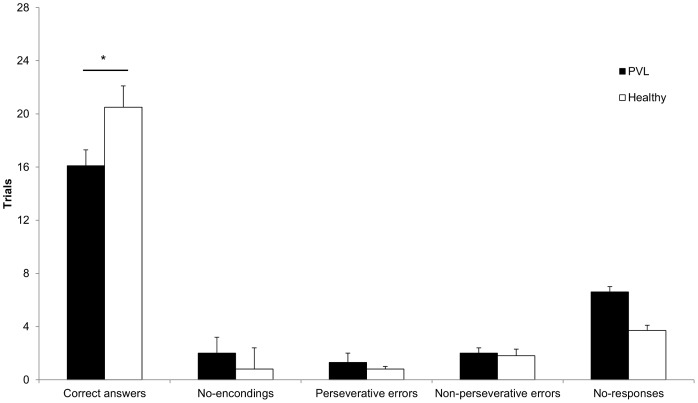
Correct and incorrect responses on the VSWMT.Responses to the VSWMT are shown in black for the PVL group and in white for the healthy group. The PVL group showed a lower number of correct responses than did the healthy group (*p≤0.05). For the different types of incorrect responses, no significant differences were identified.